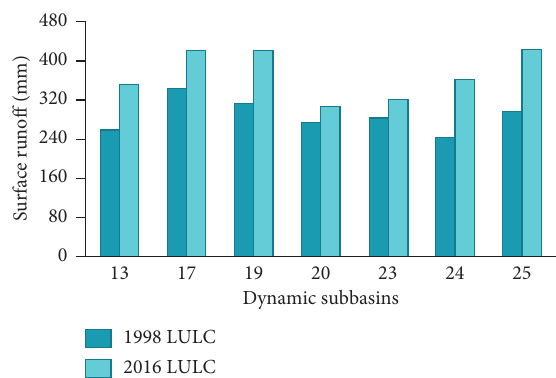
Figure 15: Comparison of simulated surface runoff (mm) for selected dynamic subbasins. Table 12: Summary of simulated mean annual runoff (mm) comparison at the subbasin level.